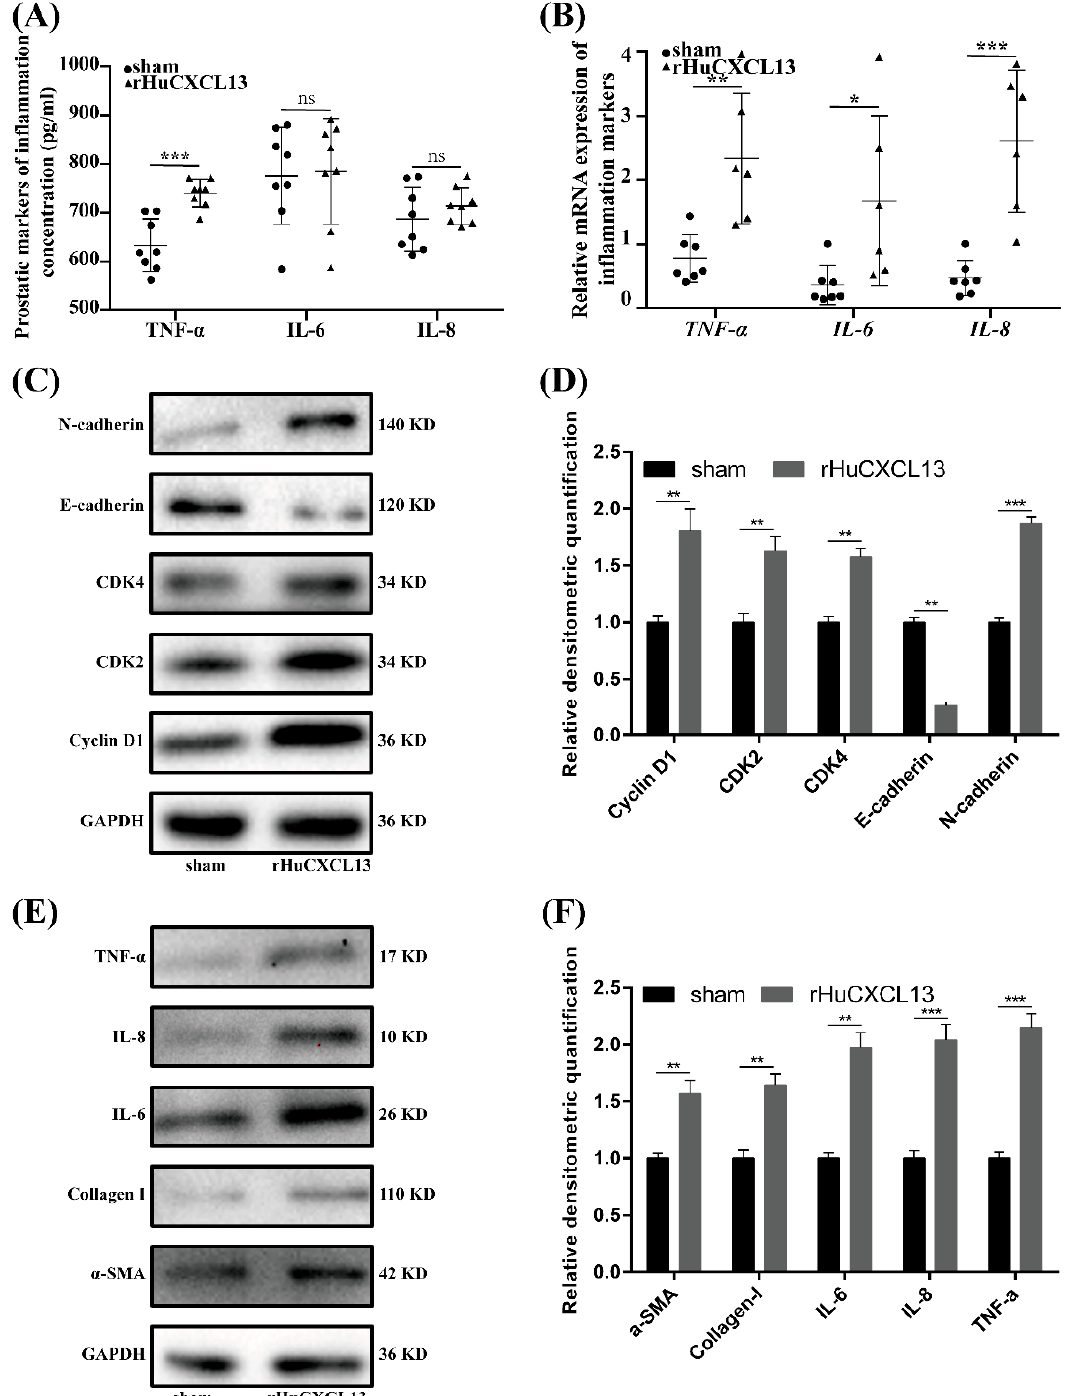
Figure 8. rHuCXCL13 induces the development of BPH in vivo. ( A ) Concentration of inflammation markers in rat blood. ( B ) Relative mRNA expression of inflammation markers in rat prostate tissues. ( C ) Western blot assay of cell-cycle- and EMT-related proteins in sham and rHuCXCL13-treated rat prostate tissues. ( D ) Relative densitometric quantification of cell-cycle- and EMT-related proteins in sham and rHuCXCL13-treated rat prostate tissues. ( E ) Western blot assay of fibrosis- and inflammation-related proteins in sham and rHuCXCL13-treated rat prostate tissues. ( F ) Relative densitometric quantification of fibrosis- and inflammation-related proteins in sham and rHuCXCL13-treated rat prostate tissues. * p < 0.05, ** p < 0.01, *** p < 0.001 and ns means no significant difference.